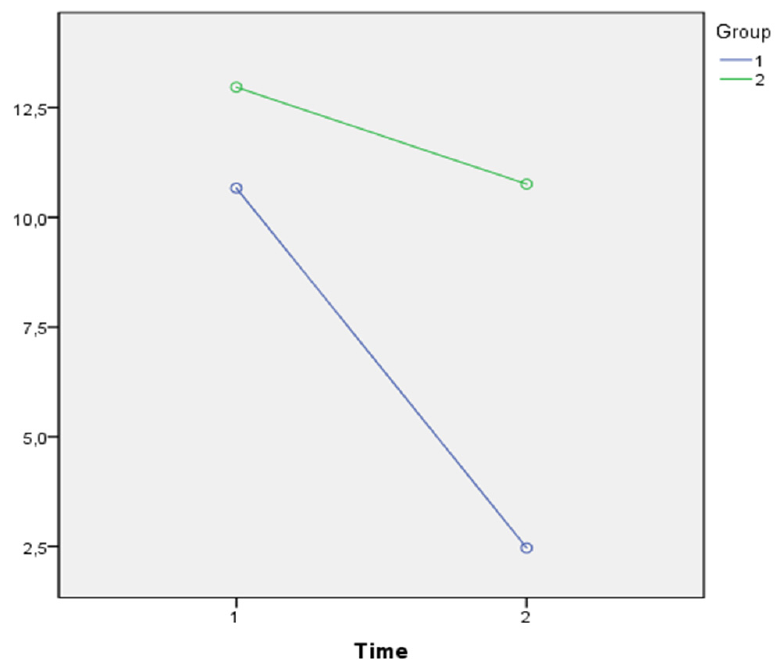
Figure 4. Comparison of the average NPI_distress in the EG (purple line) and in the CG over time (green